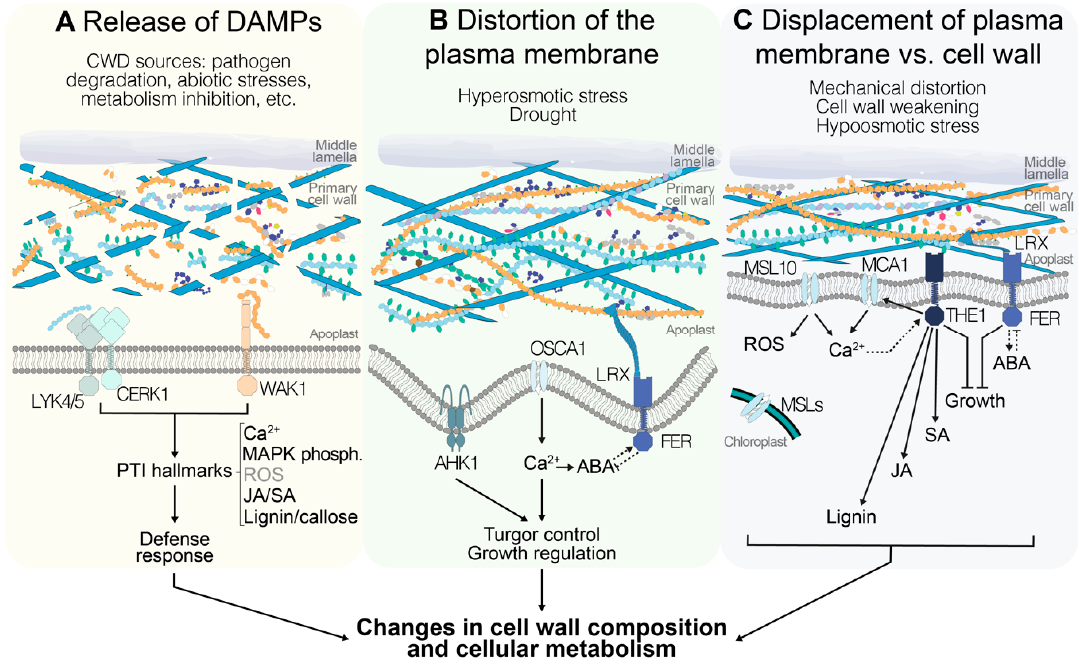
Figure 2. Different stimuli could indicate alterations in cell wall integrity (CWI) in Arabidopsis thaliana , and are perceived through different signaling pathways. ( A ) Release of cell wall fragments, also known as damage-associated molecular patterns (DAMPs), is interpreted by the plant as the result of cell wall damage (CWD) that can derive from biotic and abiotic stresses as well as endogenous processes. DAMP perception by pattern-recognition receptors activates typical immunity responses including increases in cytoplasmic [Ca 2+ ], phosphorylation of mitogen-activated protein kinases (MAPKs), production of jasmonic acid(JA)/salicylic acid (SA), reactive oxygen species (ROS), and lignin, and callose deposition. ( B ) Distortion of the cell wall–plasma membrane continuum occurs in response to plasma membrane shrinkage during hyperosmotic stress (drought). Mechanosensitive ion channels mediate Ca 2+ influx into the cytoplasm, leading to the activation of signal transduction pathways. Moreover, interactions between abscisic acid (ABA) and FER modulate growth in response to the state of turgor pressure. ( C ) If the plasma membrane is stretched, either by a weakened cell wall or as result of hypoosmotic stress, mechanosensitive ion channels are activated and [Ca 2+ ] in the cytoplasm is increased. Several of these channels are also required for the production of ROS. Moreover, THE1-mediated signaling modulates CWD-induced lignin and JA/SA production, and together with FER leads to growth arrest until CWI is recovered. The pathways in A , B , and C eventually lead to a series of changes in cell wall composition and cellular metabolism, enabling the plant to maintain CWI in response to different challenges.